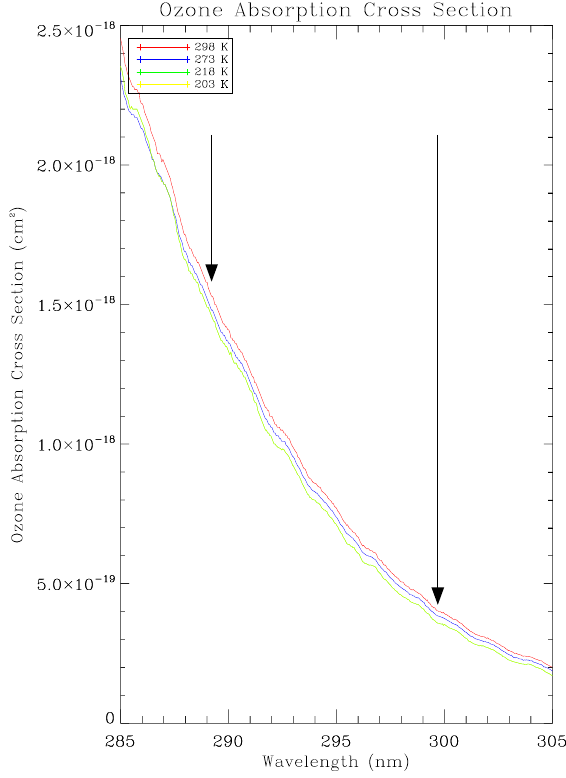
Figure 1. The spectral dependence of the ozone absorption cross section in the UV. The more absorbing wavelength, at 288.9nm, is called the “on” wavelength; the less absorbing wavelength, at 299.1nm, is called the “off” wavelength. (Source: Malicet et al.,